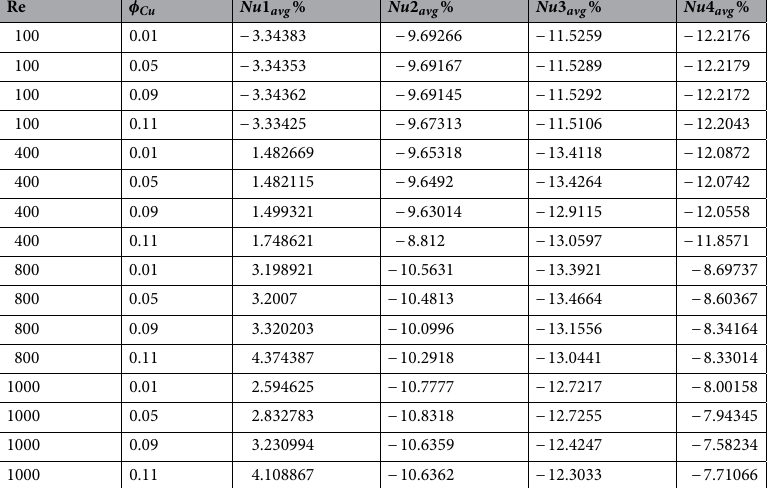
Table 4. The average Nusselt number along the middle line passing through the cavity of the channel. Here Nu 1 avg % = The percentage change in the average Nusselt number when the aspect ratio is turned from 1 to 1.5 Nu 2 avg % = The percentage change in the average Nusselt number when the aspect ratio is turned from 1.5 to 2 Nu 3 avg % = The percentage change in the average Nusselt number when the aspect ratio is turned from 2 to 2.5 Nu 4 avg % = The percentage change in the average Nusselt number when the aspect ratio is turned from 2.5 to